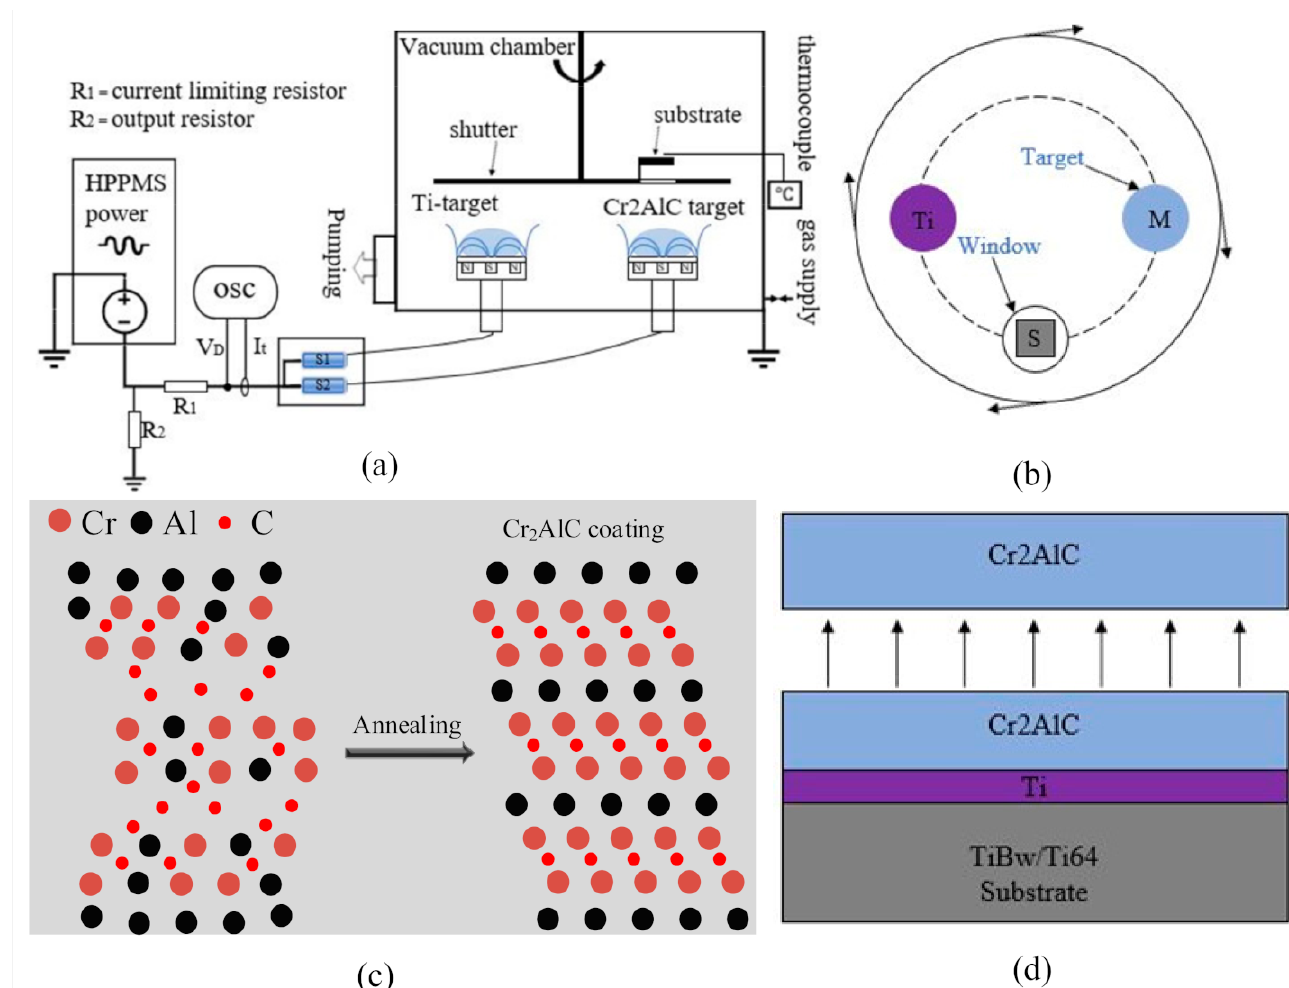
Figure 1. Schematic of the deposition process: ( a ) JGP560 sputtering system with high-power impulse magnetron sputtering (HiPIMS) power source; ( b ) arrangement of magnetron targets inside the vacuum chamber (top view), where “S” and “M” represent substrate and MAX compound target, respectively; ( c ) formation mechanism of Cr 2 AlC coatings followed by ex situ annealing; and ( d ) design of Cr 2 AlC coating system on TiBw/Ti64 substrate having a Ti buffer layer between Cr 2 AlC coating and substrate (arrows illustrate the thickness of deposited